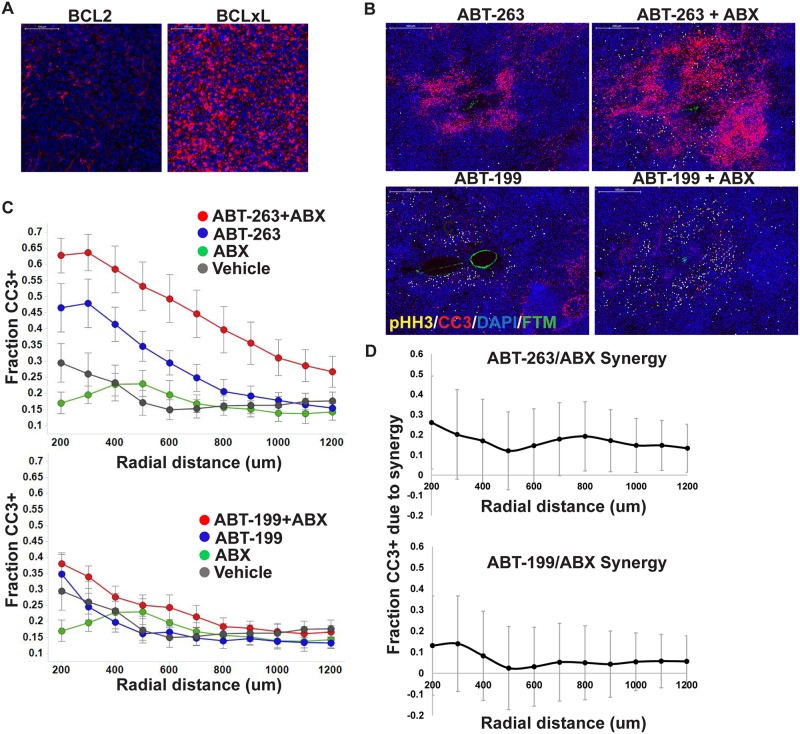
CIVO combination analysis leads to identification of a synergistic combination between ABT-263 and Abraxane® but not with other selective BCL2 inhibitor, ABT-199.(A Representative images show immunohistochemical staining of target proteins BCL2 (ABT-263 and ABT-199) and BCLxL (ABT-263 only) in MiaPaCa2 xenograft tumors. (B) Using the CIVO device, MiaPaCa2 tumors were injected with vehicle, ABT-199, ABX, ABT-199+ABX or vehicle, ABT-263, ABX, ABT-263+ABX into each of 5 tumors per combination set and resected 24 hours post injection. Tissue sections were stained with cleaved caspase 3 (CC3) as a marker of apoptosis, phospho Histone H3 (pHH3) as a marker of mitotic arrest with DAPI as the counterstain. FTM demarcates the site of injection. Representative images show localized cytotoxic responses induced by ABT-263, ABT-199 and combinations thereof with ABX. (C) Plots show fraction CC3+ cells as a function of radial distance from the site of injection. Data are averaged across five tumors. Error bars denote SEM. (D) A linear mixed effects model was used to estimate the difference (βs(r)) between the response due to each combination versus the sum of the individual responses, which were plotted with 95% confidence intervals for each radial distance. Only ABT-263 showed statistically significant synergy (P<0.05; confidence intervals do not intersect 0) at several radial distances.